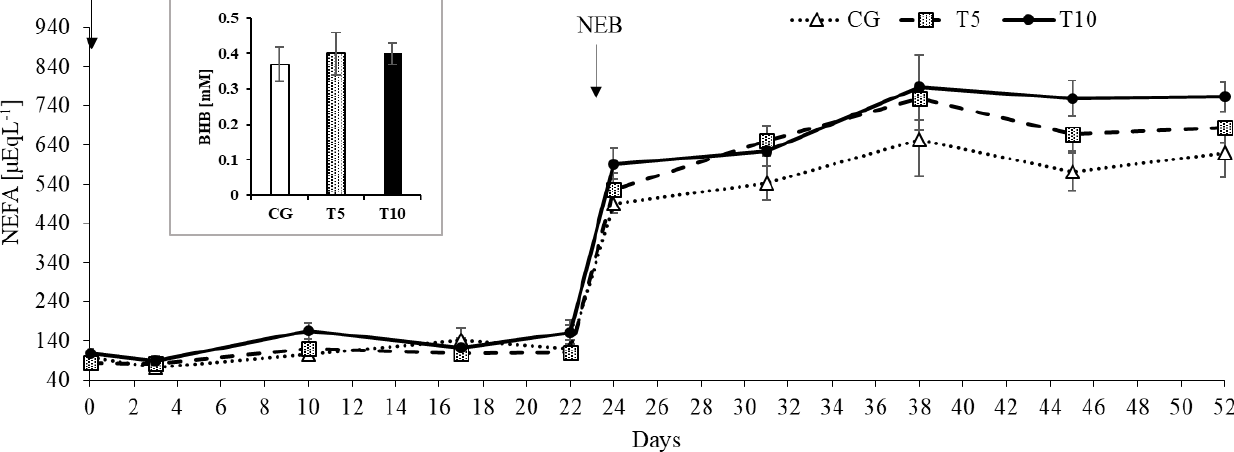
Figure 5. Non-esterified fatty acid (NEFA) response under positive (PEB) and negative (NEB) energy balance states in the